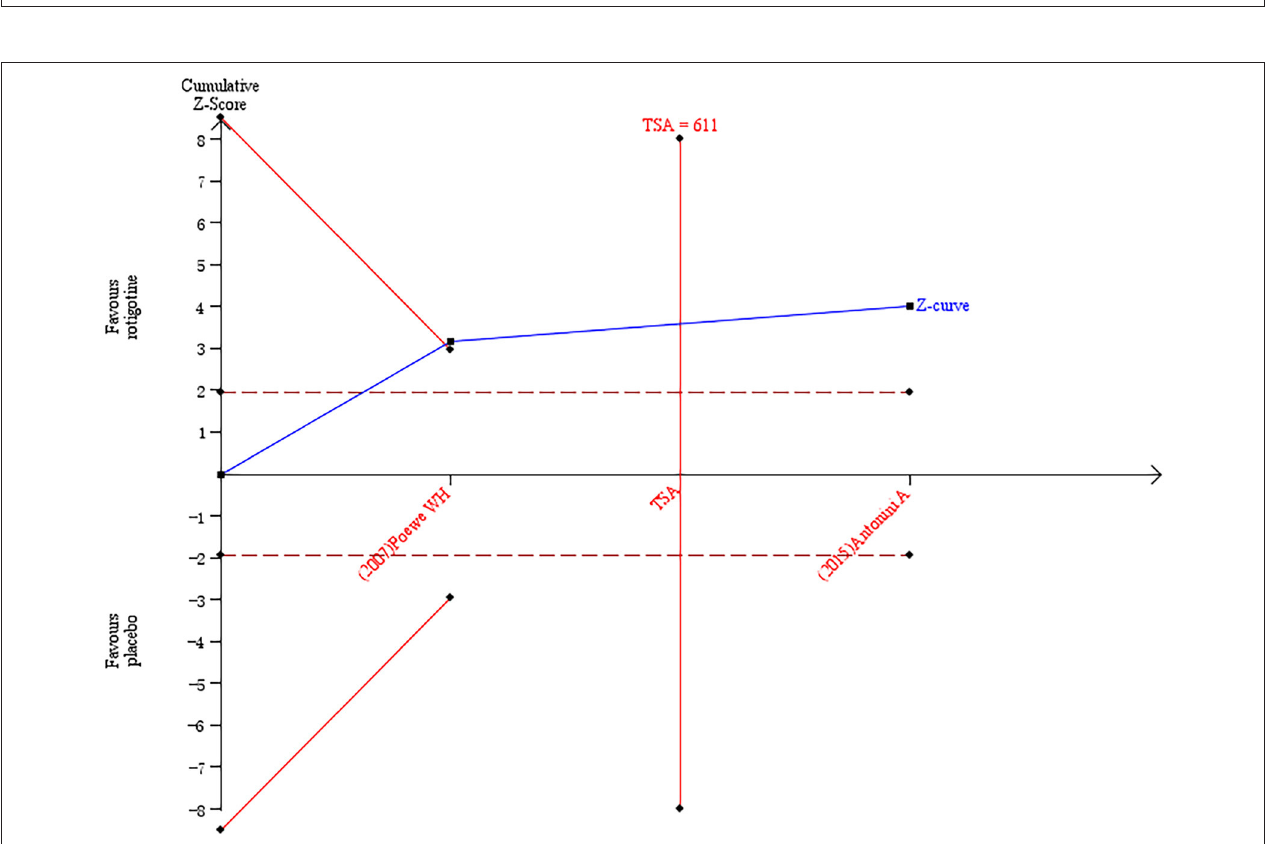
FIGURE 9 | Trial sequential analysis of the cumulative meta-analysis of the effect of rotigotine vs. placebo on PDQ-39 score in Parkinson’s disease patients.